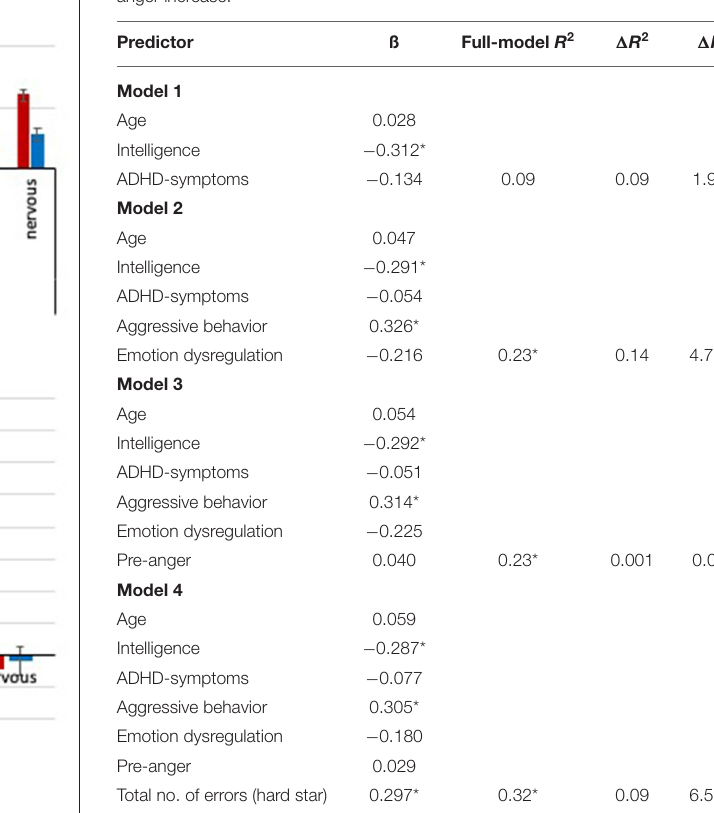
TABLE 3 | The relationship of aggressive behavior, emotion dysregulation, baseline anger (pre-anger), and level of frustration (no. of errors at hard star) to anger